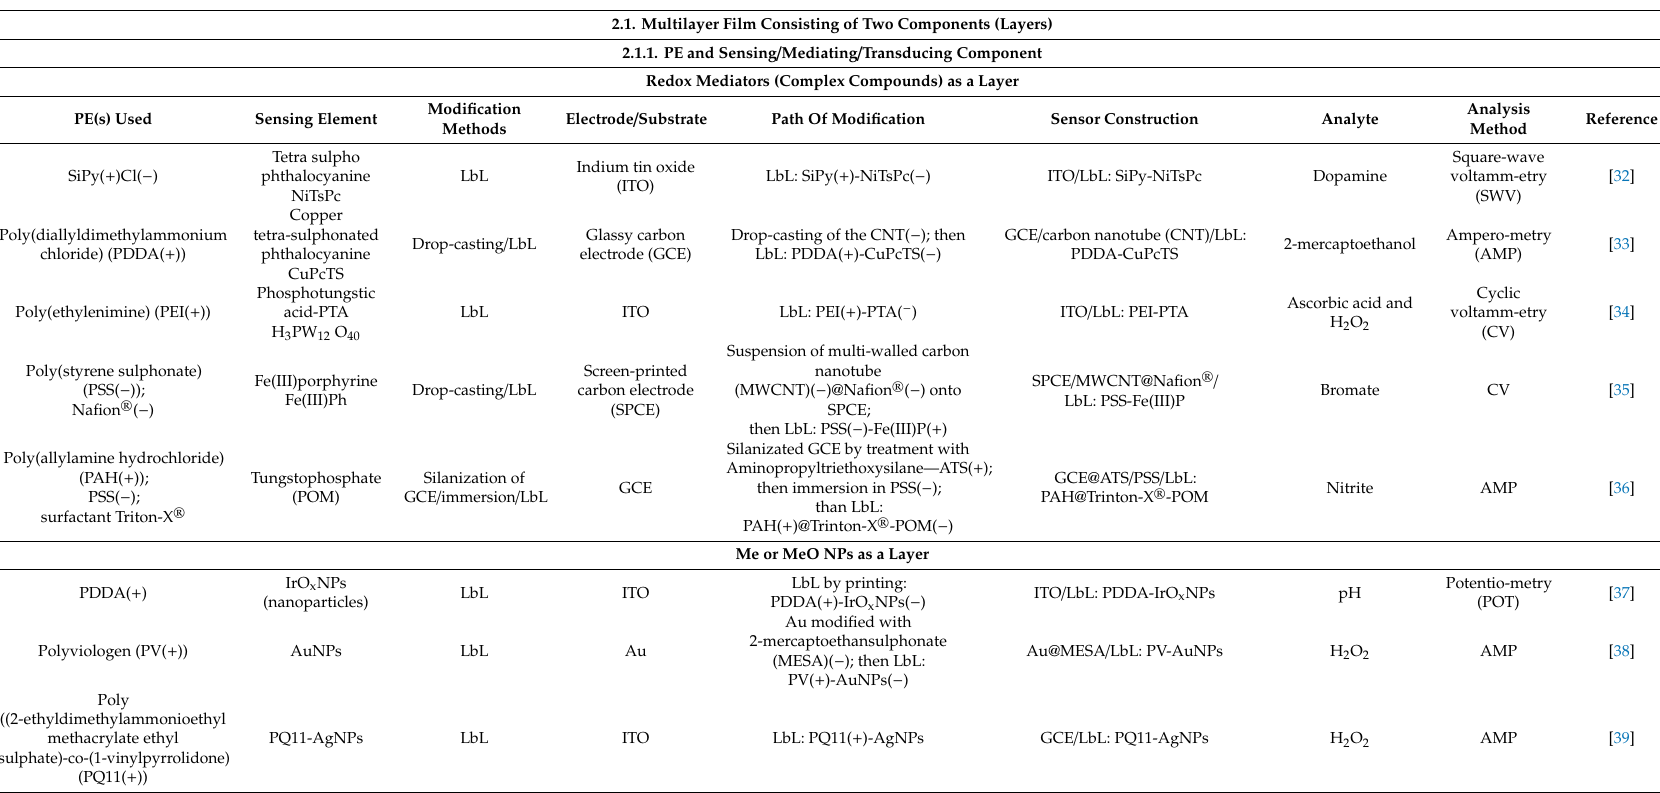
Table 1. Summary list of electrochemical sensors based on sensing multilayer films (prepared by the LbL method) consisting of two components that act as self-containing